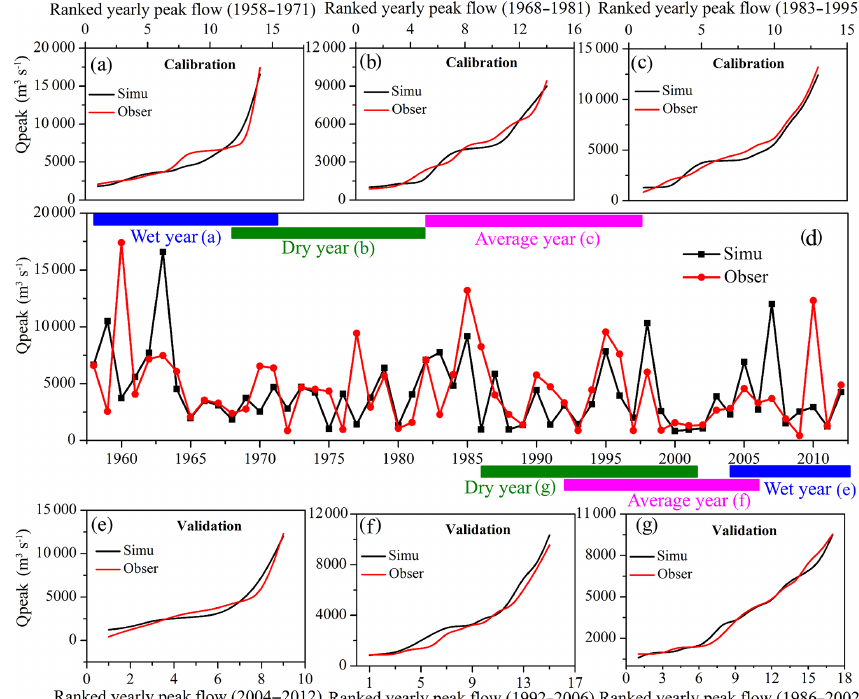
Figure 4. Comparisons of simulated and observed peak discharge of the Ai River (Yalu River tributary): (a–c) show ranked peak flows for model simulations and observations for wet, average, and dry years during the calibration period, respectively; (e–g) show ranked peak flows between the model simulations and observations for wet, average, and dry years during the validation period, respectively; and (d) is the time-series comparison of simulated and observed daily peak flow during